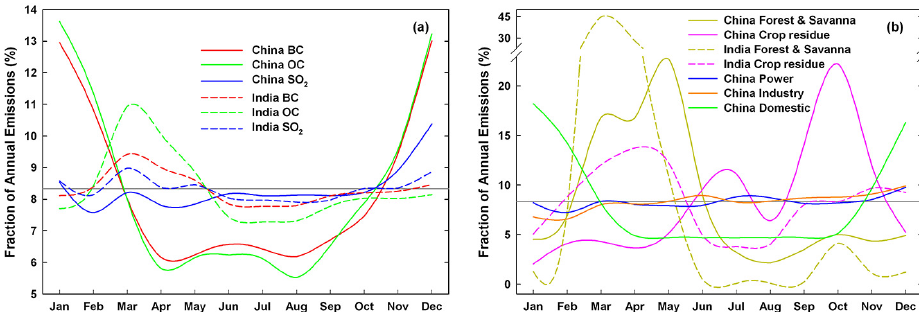
Fig. 9. Average seasonality of SO 2 , BC, and OC emissions (a) and monthly profiles of major sectors (b) in China and India during 1996–